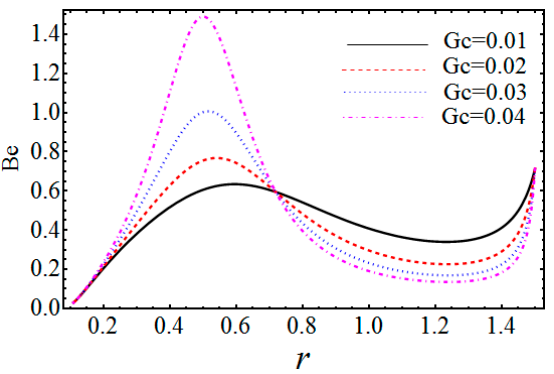
Figure 19. Curves of Be with fixed Gc where θ = 0.1, ϕ = 0.5, δ = 0.1, ε = 0.01, V = 0.3, λ 1 = Figure 19. Curves of 𝐵𝑒 with fixed 𝐺𝑐 where 𝜃 = 0.1, 𝜑 = 0.5, 𝛿 = 0.1,𝜀 = 0.01,𝑉 = 0.3, 𝜆 (cid:2869) = 0.1, z = 0, t = 0.1, Ω = 0.3, Λ = 1, Nt = 0.5, Br = 1, Gr = 5, Γ = 0.4, Nb = 0.9, Q = 0.1, 𝑧 = 0, 𝑡 = 0.1, Ω = 0.3, Λ = 1, 𝑁𝑡 = 0.5, 𝐵𝑟 = 1, 𝐺𝑟 = 5, Γ = 0.4, 𝑁𝑏 = 0.9, 𝑄 = 1.